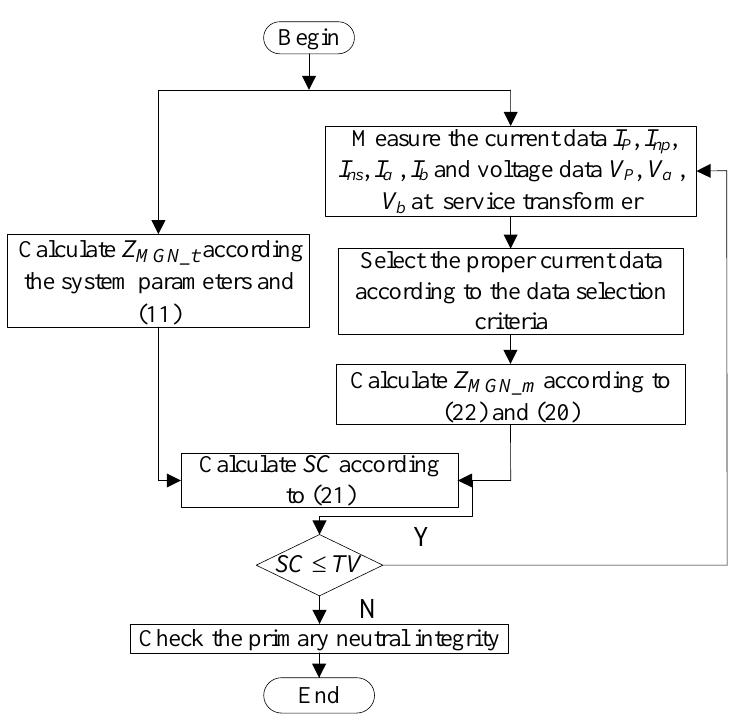
Figure 7. Flowchart of the proposed method for monitoring the primary neutral integrity.